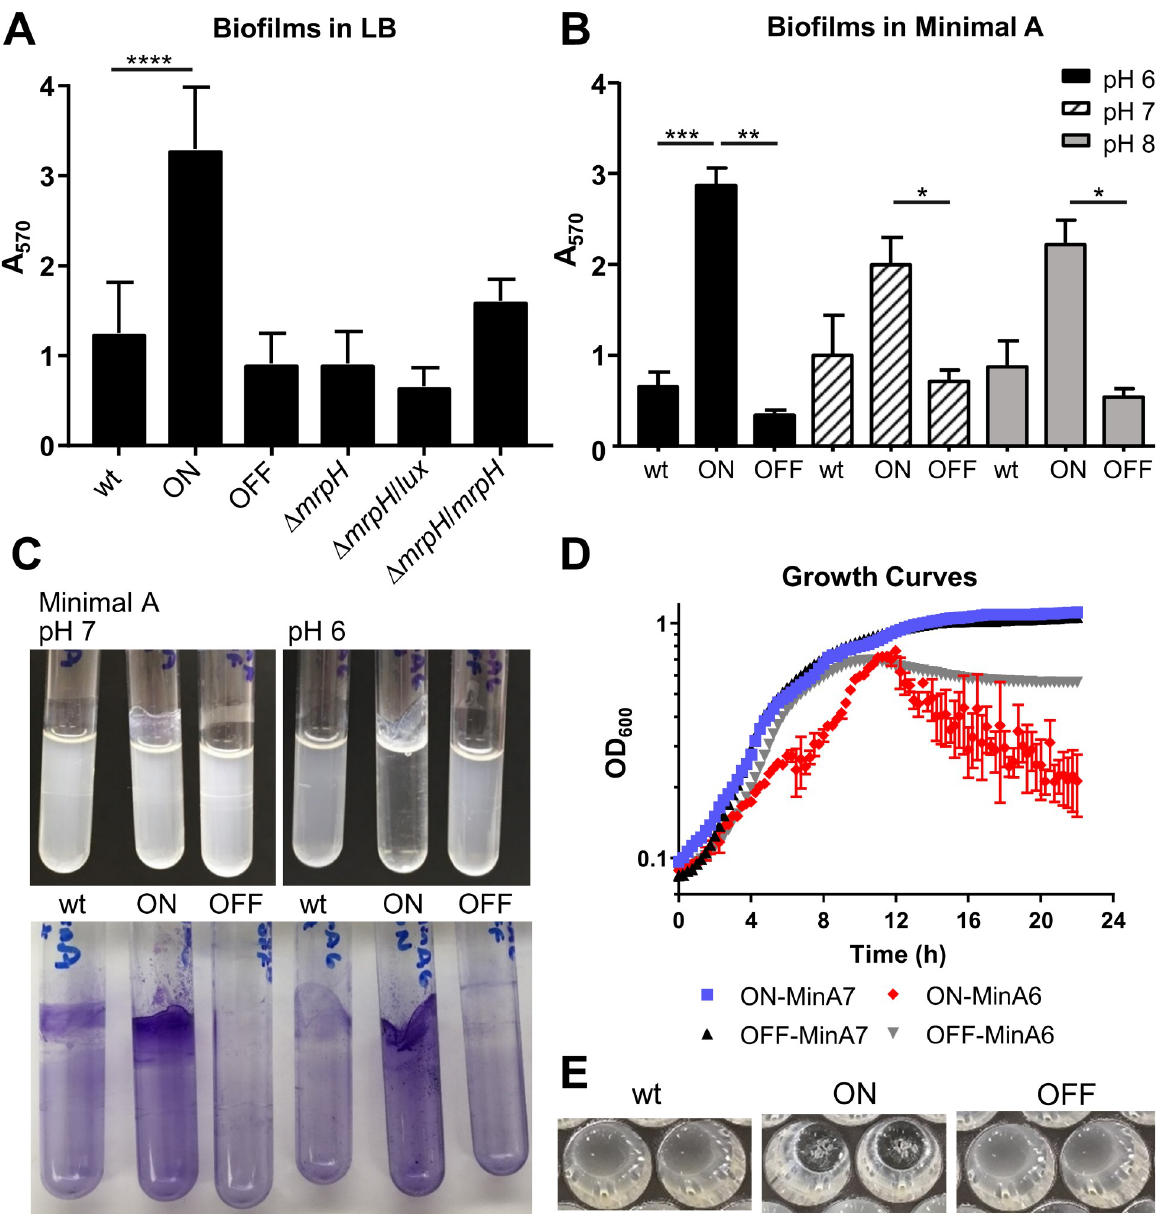
Fig 6. Biofilm formation is dependent on MR/P fimbriae and pH. (A) Biofilm formation in LB medium. MR/P locked-ON formed significantly more biofilm than all other tested strains. Wild-type biofilm formation trended higher than MR/P locked-OFF, but the difference was not significant. The last three columns show an mrpH mutant ( Δ mrpH ), either without a plasmid or complemented with pGEN-Pmrp- lux or pGEN-Pmrp- mrpH . (B-D) Biofilm formation was more pronounced at acidic pH. (B) Quantification of biofilm formation in Minimal A. Significance calculated using one-way ANOVA with Dunnett’s multiple comparisons test. (C) Representative biofilm cultures (top) and biofilm staining (bottom). (D) Growth curve analysis of P . mirabilis HI4320 L-ON and L-OFF at pH 6 and 7. (E) Growth curve wells showing floating pellicles for L-ON and planktonic growth for wild type and